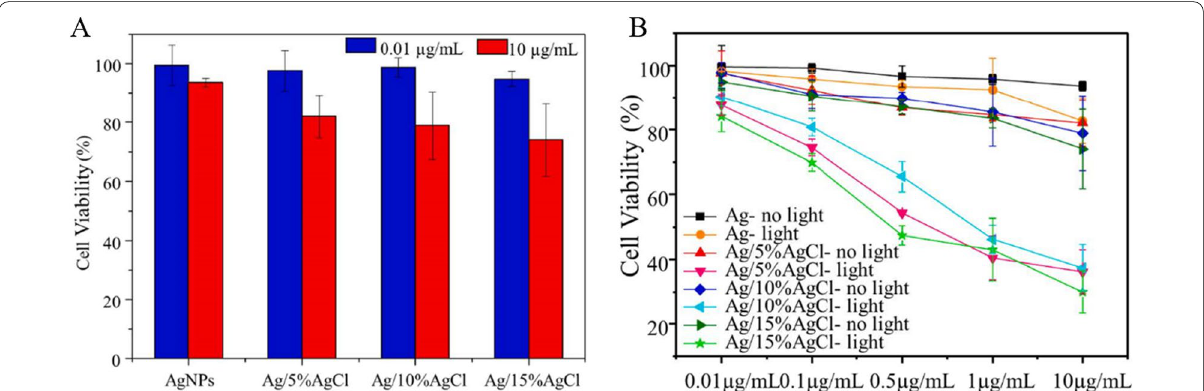
Fig. 4 A The cell viability of Ag and different ratios of AgCl at Ag treated HeLa cells in a dark environment. B The comparison of HeLa cell viability treated by Ag and Ag/AgCl with or without simulated sunlight. Adapted from Ref. [68] with permission. Copyright (2022), Chemical Engineering